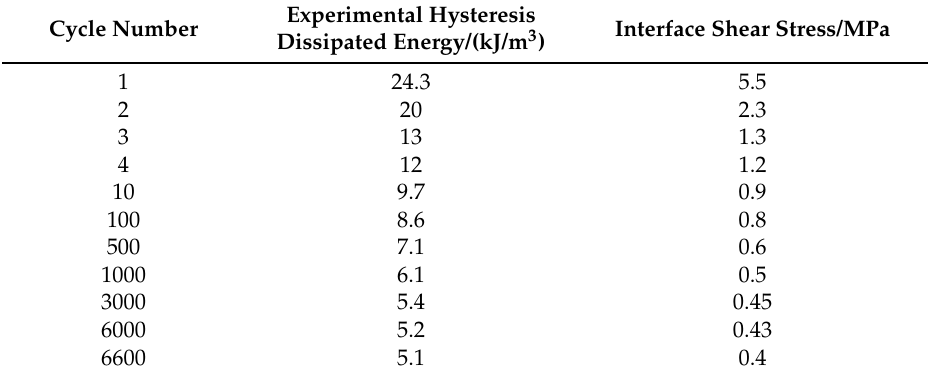
Table 5. The interface shear stress of cross-ply C/SiC composite corresponding to different applied cycles under fatigue peak stress of σ max = 105 MPa at 800 ◦ C in air. Experimental Hysteresis Interface Shear Stress/MPa Cycle Number Dissipated Energy/(kJ/m 3 )